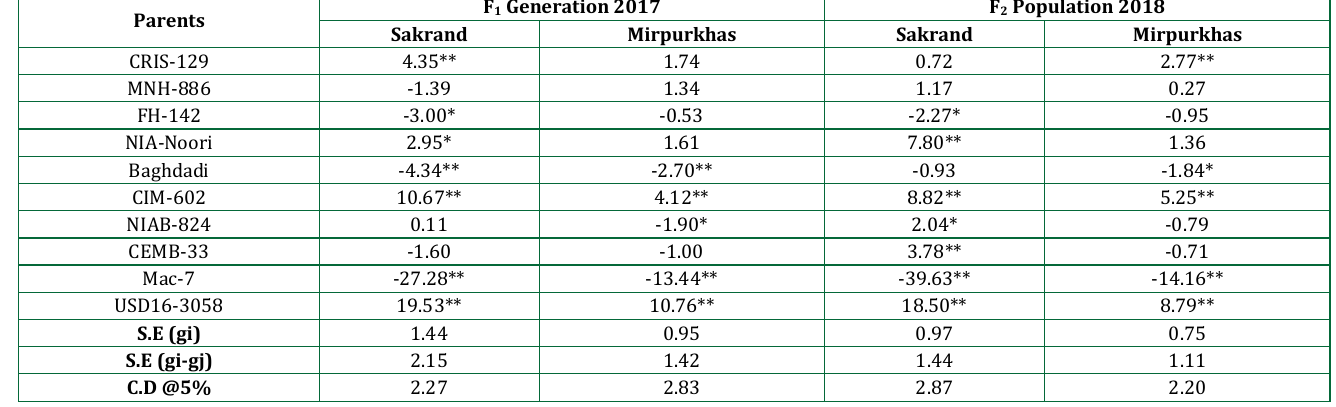
Table 3: General Combining Ability (GCA) Effects For Cotton Leaf Curl Virus Disease Incidence %. Parents